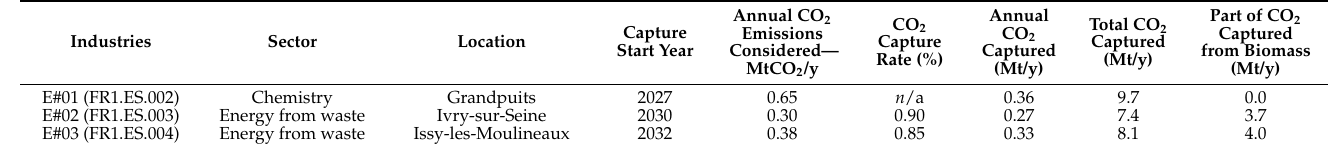
Table 3. Industries considered in the scenario with their features and carbon emissions detailed after capture.